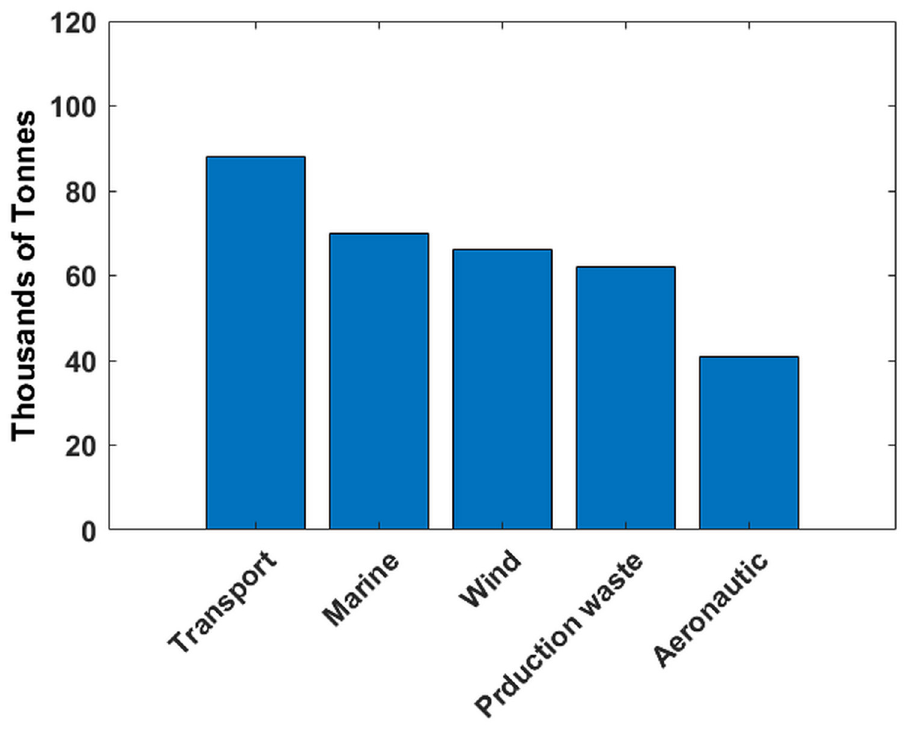
Figure 2. Prevision of waste production per sector in thousands of tons by 2025 [17].